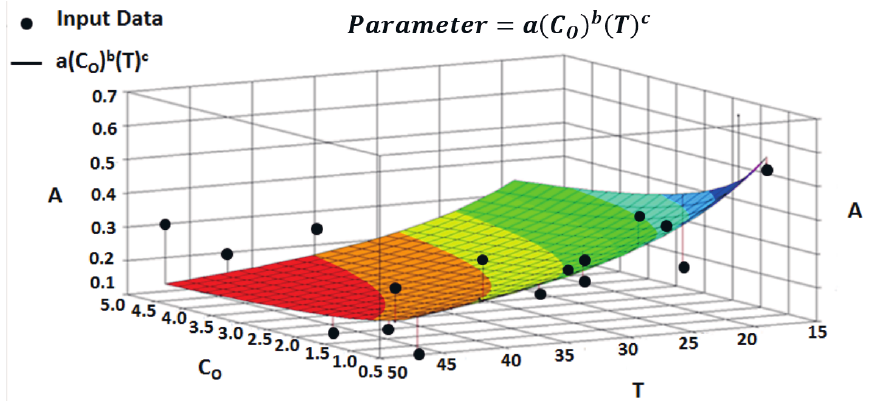
Figure 4. Multivariate function resulting from regression for chlorine parameter (cid:2157) .